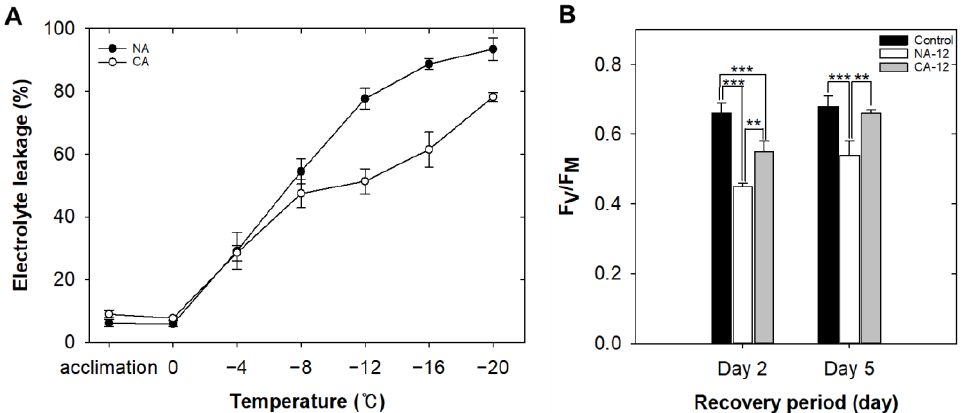
As electrolyte leakage (EL) is considered a good indicator of cell membrane in- tegrity [31], we performed an electrolyte leakage assay to compare membrane integrity and freezing sensitivity of A. turgidum protonema with cold acclimation (CA) and without (non-acclimation; NA). The protonema of A. turgidum cultured at 25 ◦ C for two weeks was transferred to a fresh BCDAT agar plate and acclimated at 4 ◦ C (CA) and 25 ◦ C (NA) under continuous light for 48 h. Then, changes in EL of protonema of A. turgidum at different sub-zero temperatures (0 to − 20 ◦ C) were examined. When the 50% electrolyte leakage (EL 50 ) of the NA and CA were compared, the temperature of CA EL 50 ( − 10.6 ◦ C) was 3.3 ◦ C lower than the temperature of NA EL 50 ( − 7.3 ◦ C). Furthermore, the greatest difference in EL of CA and NA was observed at − 12 ◦ C (Figure 2A).